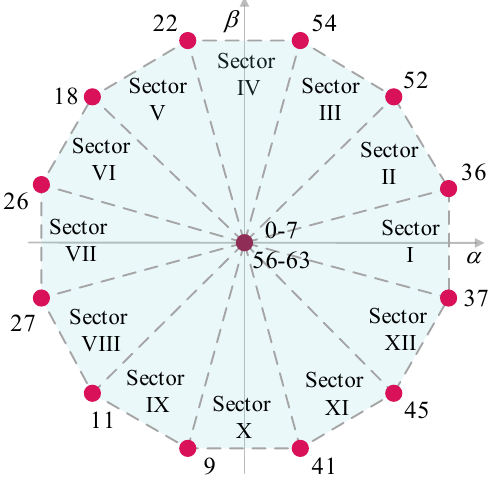
Figure 5. Voltage sectors for the selected electric